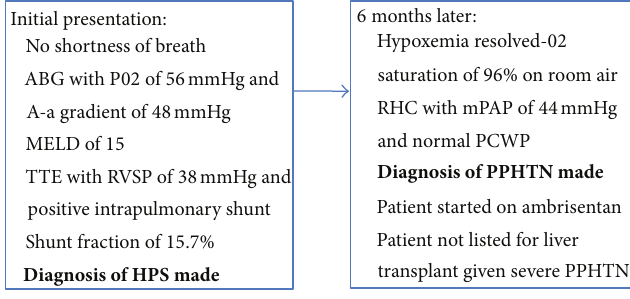
Figure 3: Sequence of events for Case